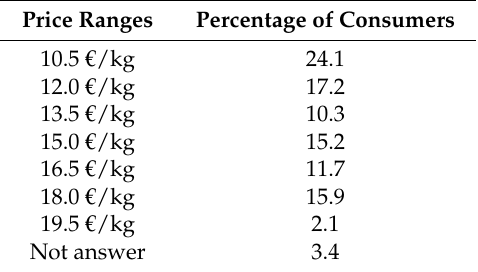
Table 2. Price ranges that consumers would be willing to pay for ‘cecina’ (percentage; n = 145 consumers). Price